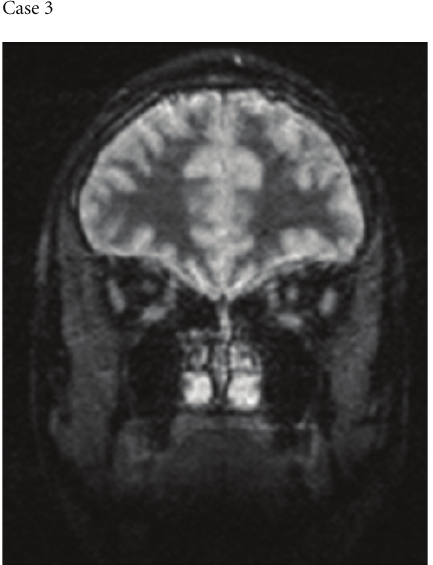
Figure 3: Coronal STIR image showing high signal within the optic nerve corresponding to the side of the pain in Case